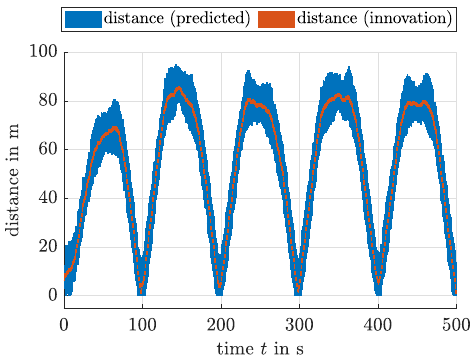
Figure 10. Interval bounds for the distance between the DDboats A and